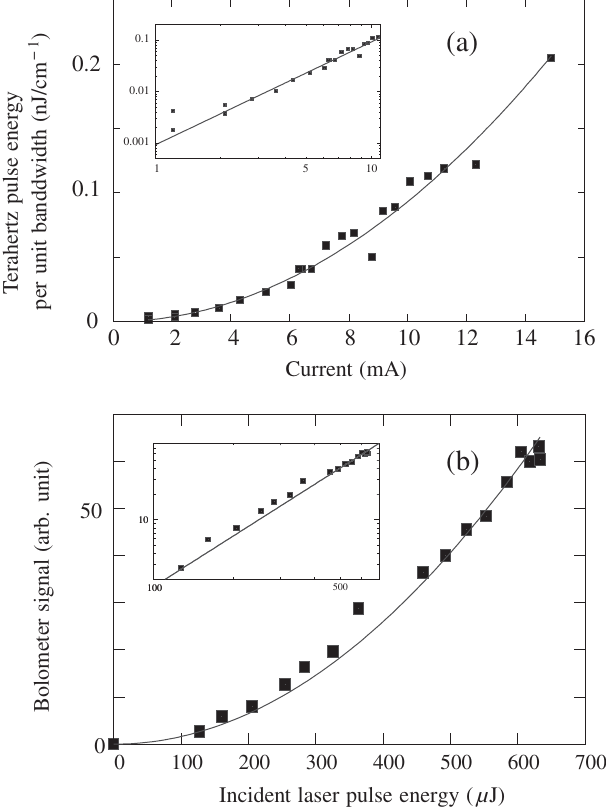
FIG. 8. Terahertz energy per bandwidth unit versus beam current (a), and versus laser pulse energy (b). Squares: experi- mental data; full line: quadratic law fit. The insets represent the same curves in log-log units. In (a), the laser pulse energy is 800 (cid:1) J . In (b), the current is 4.8 mA. The modulation wave number is 15 cm (cid:1) 1